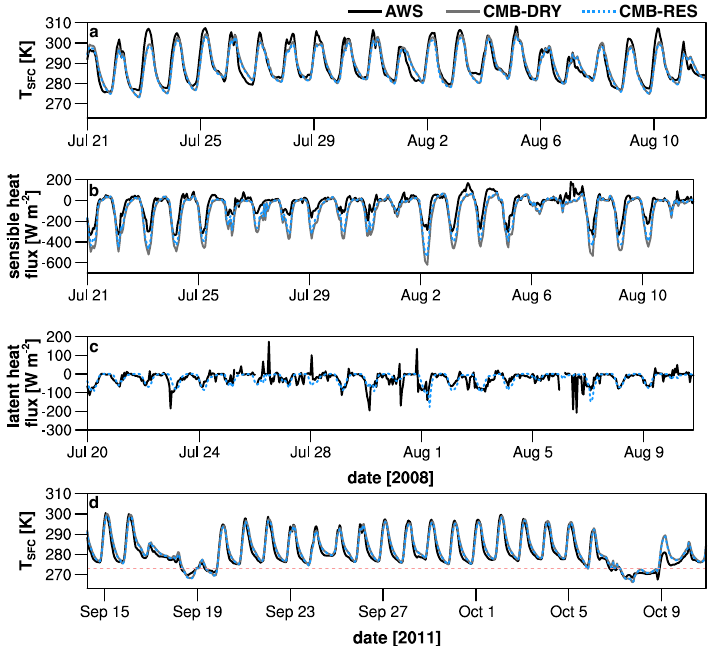
Figure 4. Time series from the 2008 simulation of (a) debris surface temperature ( T sfc ; K) and the turbulent fluxes of (b) sensible and (c) latent heat (Wm − 2 ), for measurements (black curve), CMB-DRY (dark grey curve), and CMB-RES (blue, dashed curve). (d) Same as panel a , but for the 2011 simulation. The horizontal dashed red line indicates the freezing point, 273.15K.